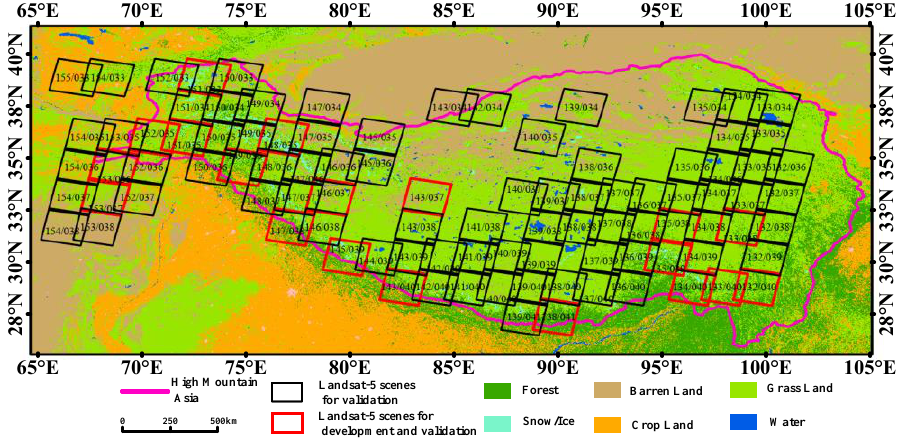
Figure 1. The land cover type map of High Mountain Asia. The spatial extent of Landsat–5 Thematic Mapper (TM).